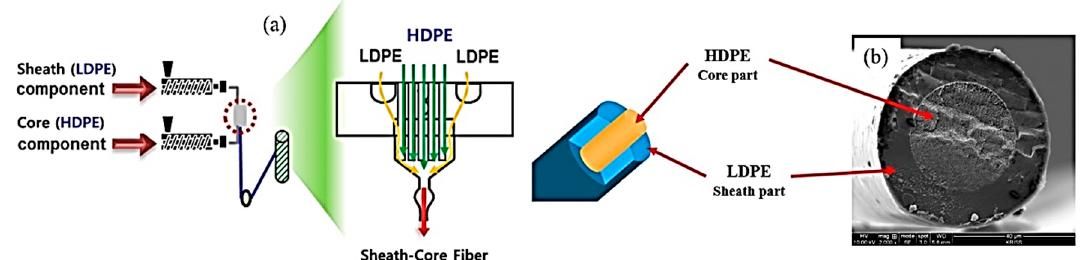
Figure 1. ( a ) Schematic melt spinning of sheath-core fiber and ( b ) SEM image of LDPE / HDPE sheath-core fiber manufactured by a conjugate core fiber manufactured by a conjugate melt-spinning.